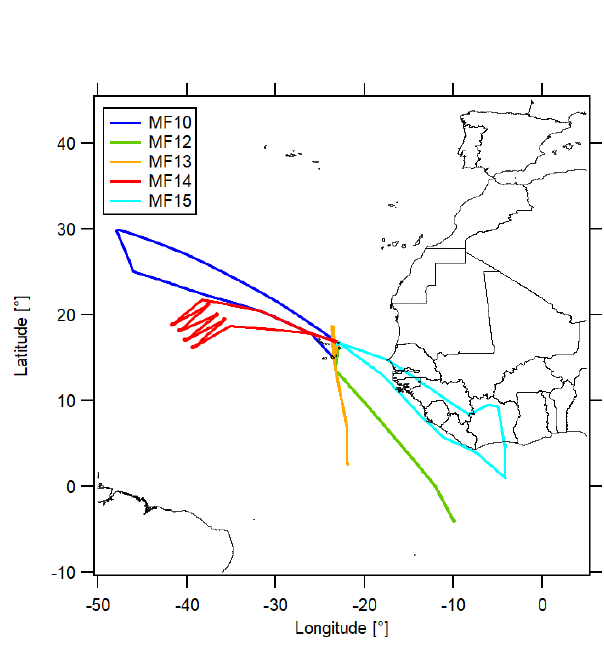
Figure 2. Geographic overview of the measurement flight tracks included in this